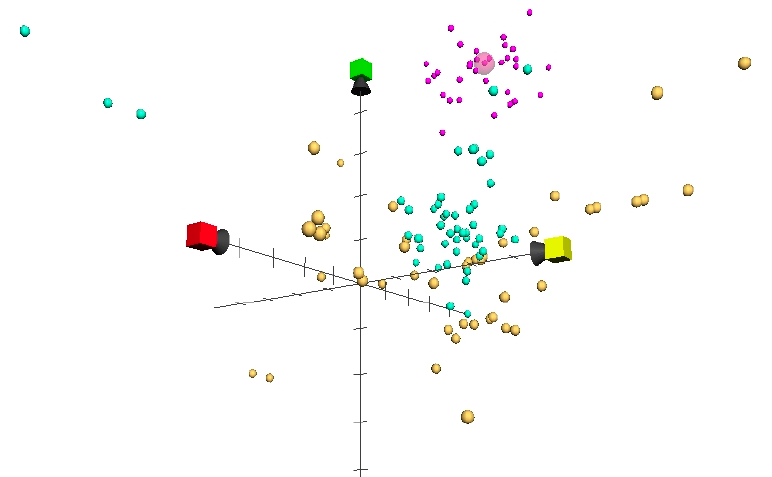
Figure 3. Three sets of 50 antituberculosis compounds classified as closest to bedaquiline (large pink sphere): ChemGPS-NP (pink), Tanimoto ecfp (turquoise), and Tanimoto maccos (orange), projected on a three-dimension space.